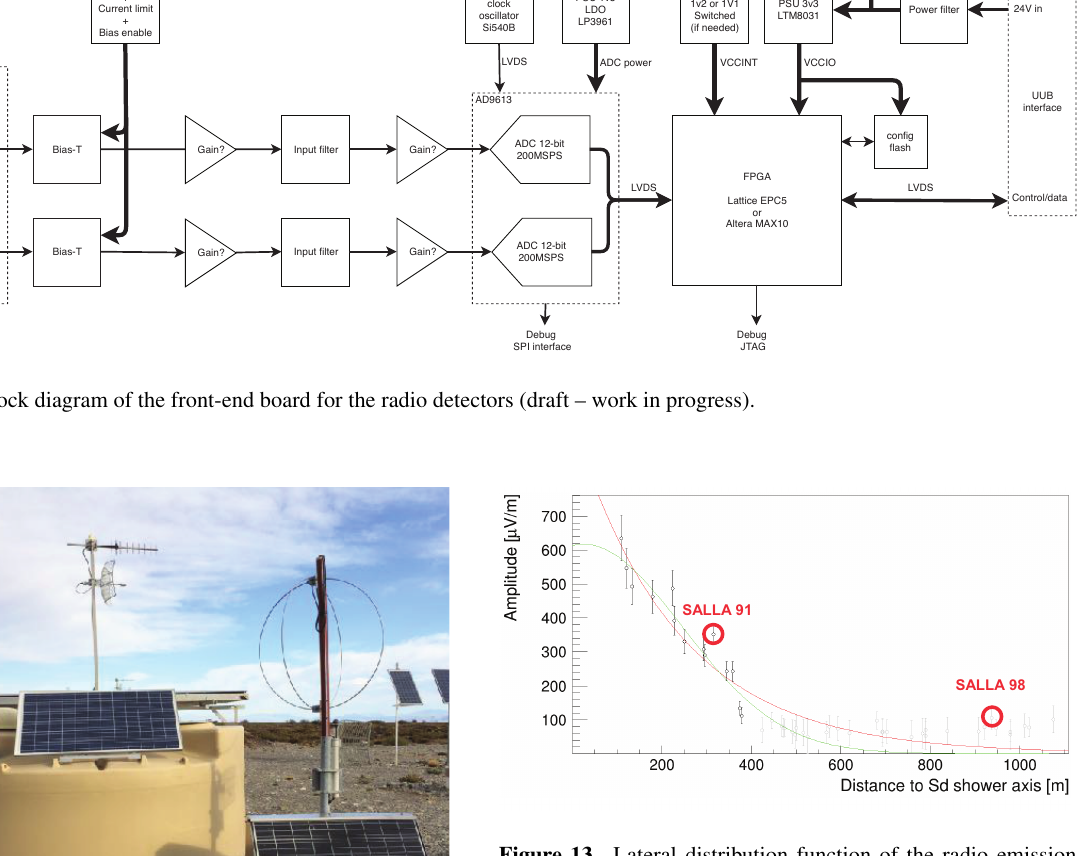
Figure 13. Lateral distribution function of the radio emission from an air shower as measured with AERA and two prototype antennas (indicated as